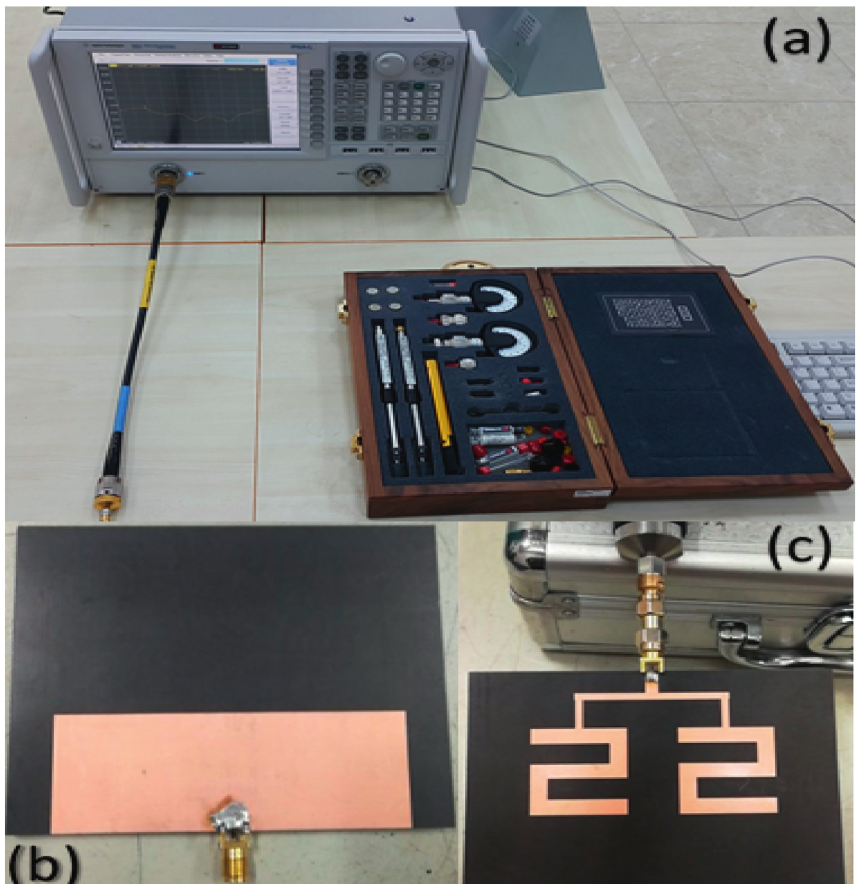
Figure 10: Photograph of a fabricated proposed meander dipole: (a) experimental set up; (b) back view; (c) fabricated antenna connecting to VNA.